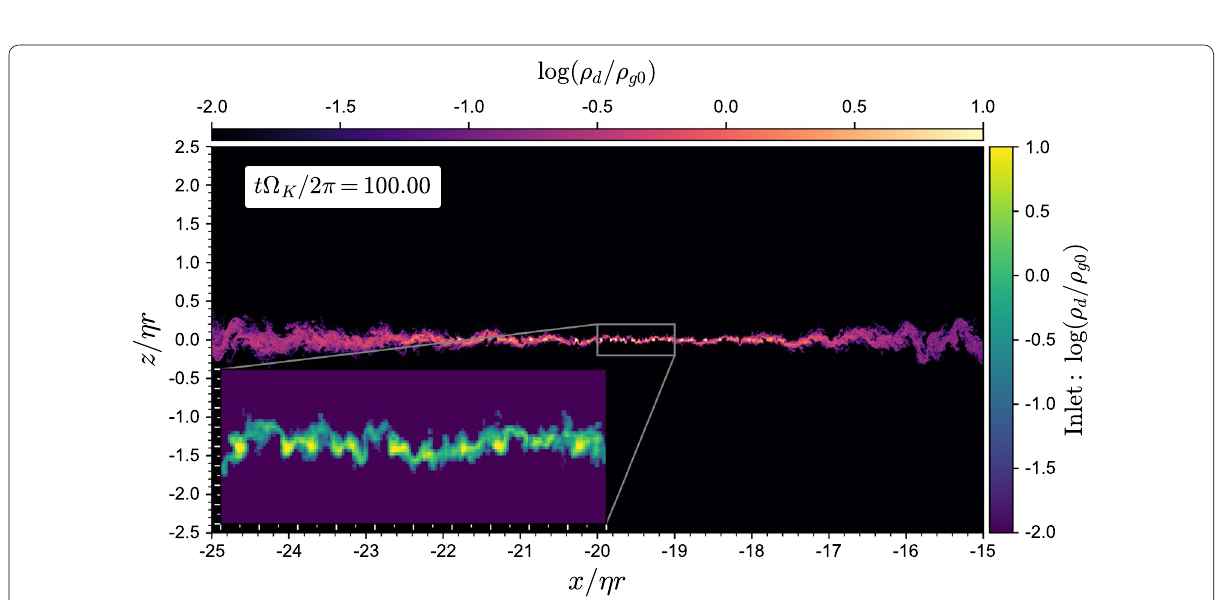
Fig. 5 Dust density distribution around x − . The dust density is normalized by ρ g